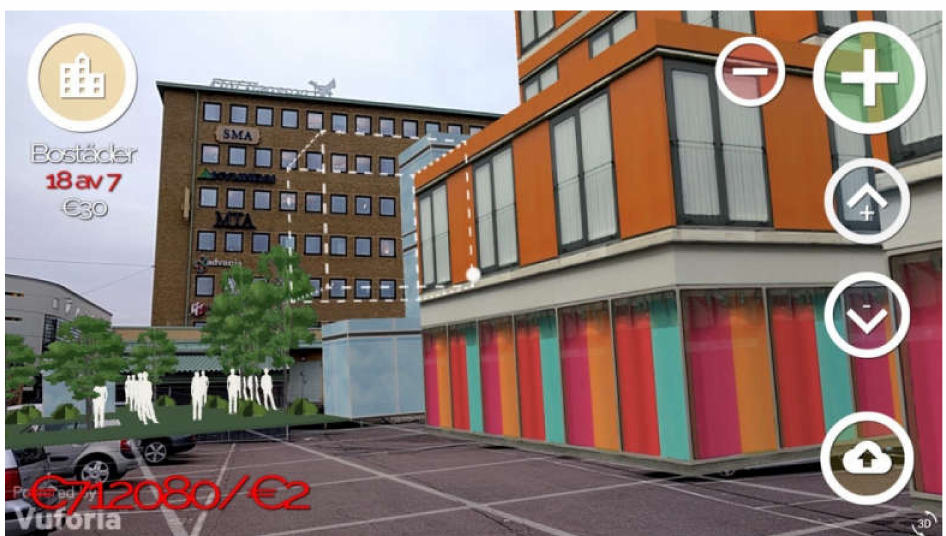
Figure 10. User interface for choosing an urban function on top left of the screen, addition and deletion buttons are on the top right. The two middle buttons indicate up or down, i.e., if to build on top of or below the selected box. The button at the bottom right indicates an upload function. The text and the numbers on the top left indicate the currently chosen urban function, available and used number of blocks, and the cost of one block of the chosen function. The numbers at the bottom left indicate available funding and remaining